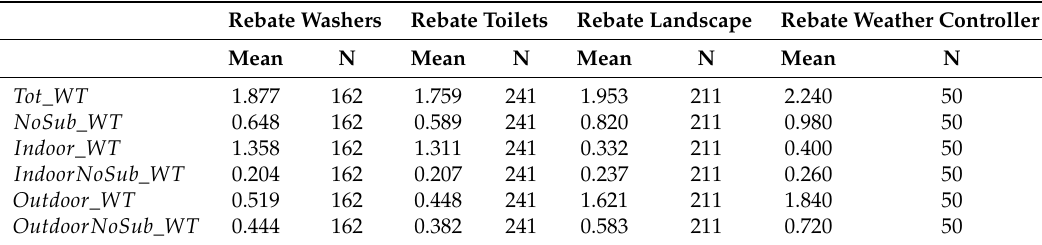
Table 3. Summary statistics—treatment households—ATET